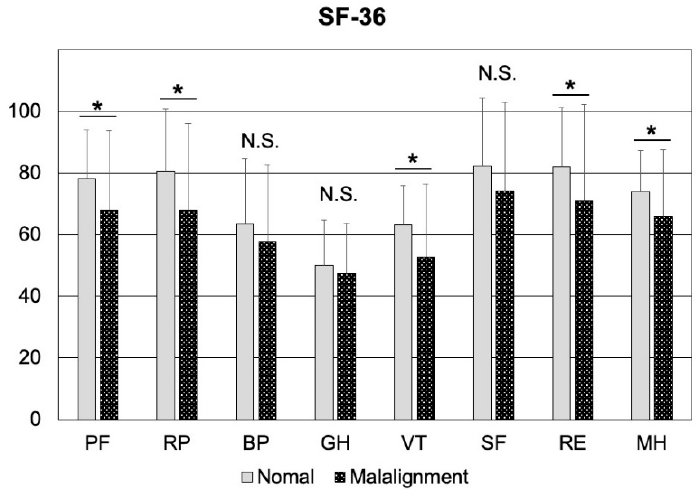
Figure 2. In patients without VFs, comparisons of ( A ) JOABPEQ, ( B ) ODI, and ( C ) VAS of LBP for patients of the normal alignment and sagittal malalignment groups are shown. VF, vertebral fracture; LBP, low back pain; ODI, Oswestry Disability Index; JOABPEQ, Japanese Orthopedic Association Back Pain Evaluation Questionnaire; VAS, Visual Analogue Scale, * p < 0.05.